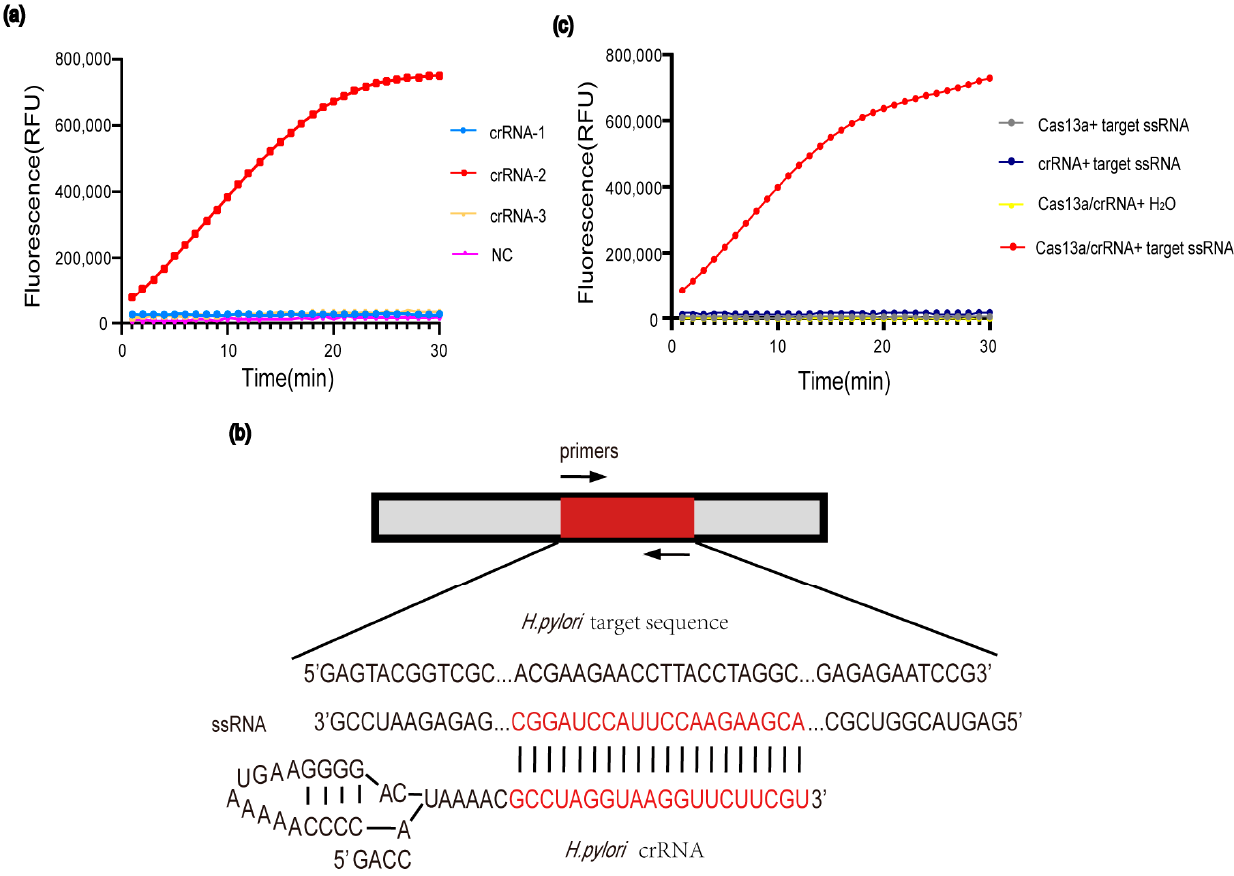
Figure 1. Development of the CRISPR-Cas13a assay. ( a ) To screen efficient crRNA, we performed CRISPR-Cas13a assay by using three designed crRNAs. ( b ) Design of crRNA based on the target sequence of H. pylori . ( c ) Activity detection of LbuCas13a.